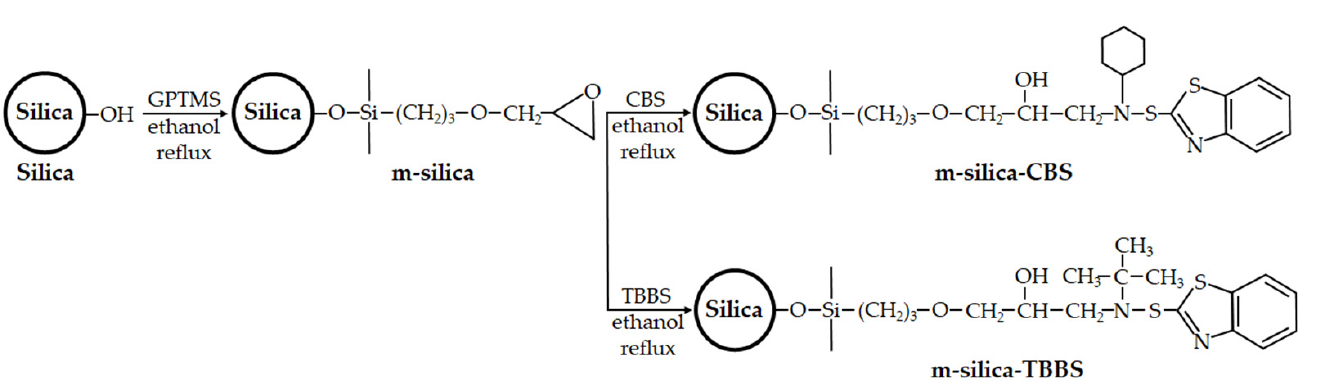
Figure 1. Chemical structures of ( a ) GPTMS, ( b ) CBS, and ( c ) TBBS.